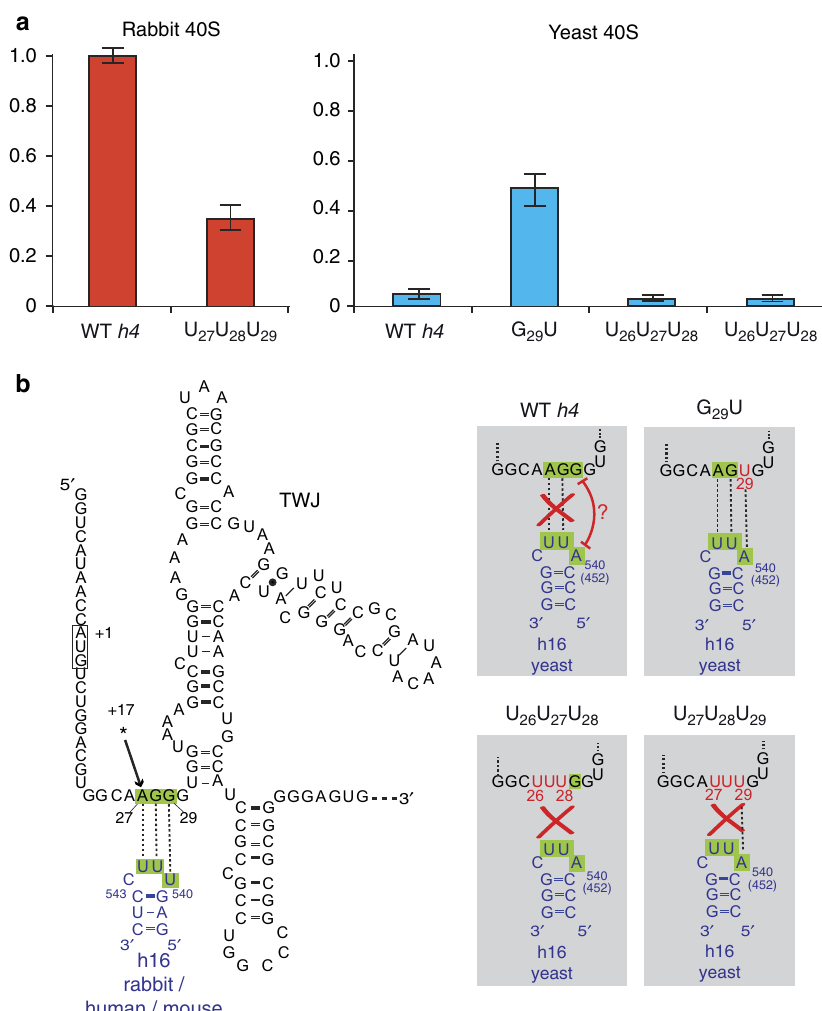
Figure 3 | Ribosome binding on h4 mRNAs. ( a ) Histogram showing 40S subunit binding on h4 mRNAs. Binding was studied on sucrose gradient with radiolabelled m 7 G-capped h4 mRNA. Samples were separated on 7–47% sucrose gradients, and complexes with 40S particles were counted in Cerenkov mode. Binding values were normalized to wild-type h4 binding with rabbit 40S particles. Values represent the average of three technical replicates. Errors bars representing the variability of data are shown. ( b ) Secondary structure of the 142 first nucleotides of murine histone h4 mRNA. The structure contains three helices connected by a TWJ followed by a stem-loop structure. The initiation codon is boxed. The black star indicates the location of the þ 17 ribosome toe-print. Partial helix 16 (h16) from yeast and mammalian (rabbit, human and mouse) are drawn in blue; nts numbering corresponds to rabbit sequence (rabbit 540 ¼ yeast 452). Mutated h4 mRNAs tested with 40S subunits from yeast are shown in the a ribosome shunt involving the 5 0 leader of the Gtx mRNA and inhibitors or cycloheximide. Five micrograms of purified and radiolabelled (250,000c.p.m.) capped h4 mRNA were incubated for 2–3h at 0 (cid:2) C in 250 m l of 18S rRNA interaction 27 , mRNA:rRNA base pairing in translation of the Gtx and FGF2 (fibroblast growth factor 2) mRNAs 28,29 . Altogether, data obtained by all these model systems suggest that base pairing with 18S rRNA could be also relevant to develop improved eukaryotic protein expression systems that bypass scanning and would imitate highly translated mRNA.